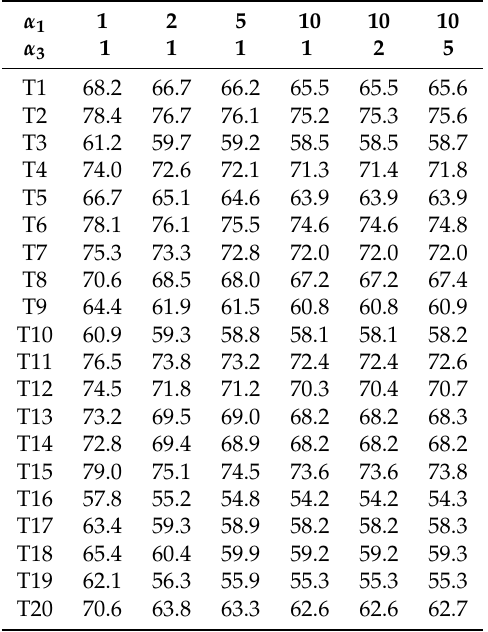
Table 5. Total schedule deviation for trains